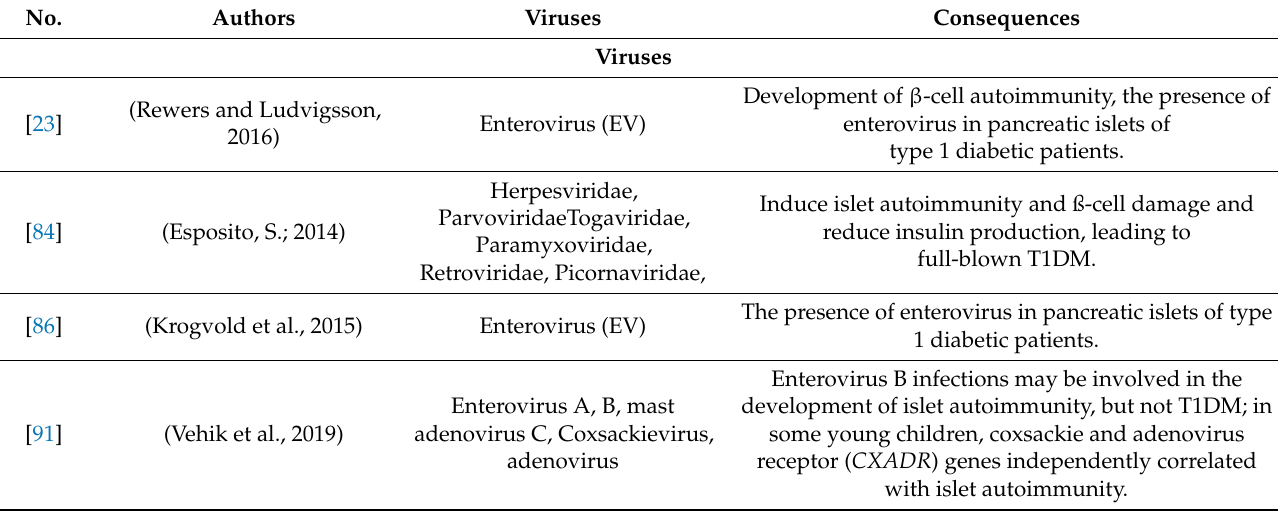
Table 2. The role of viruses in the development of type 1